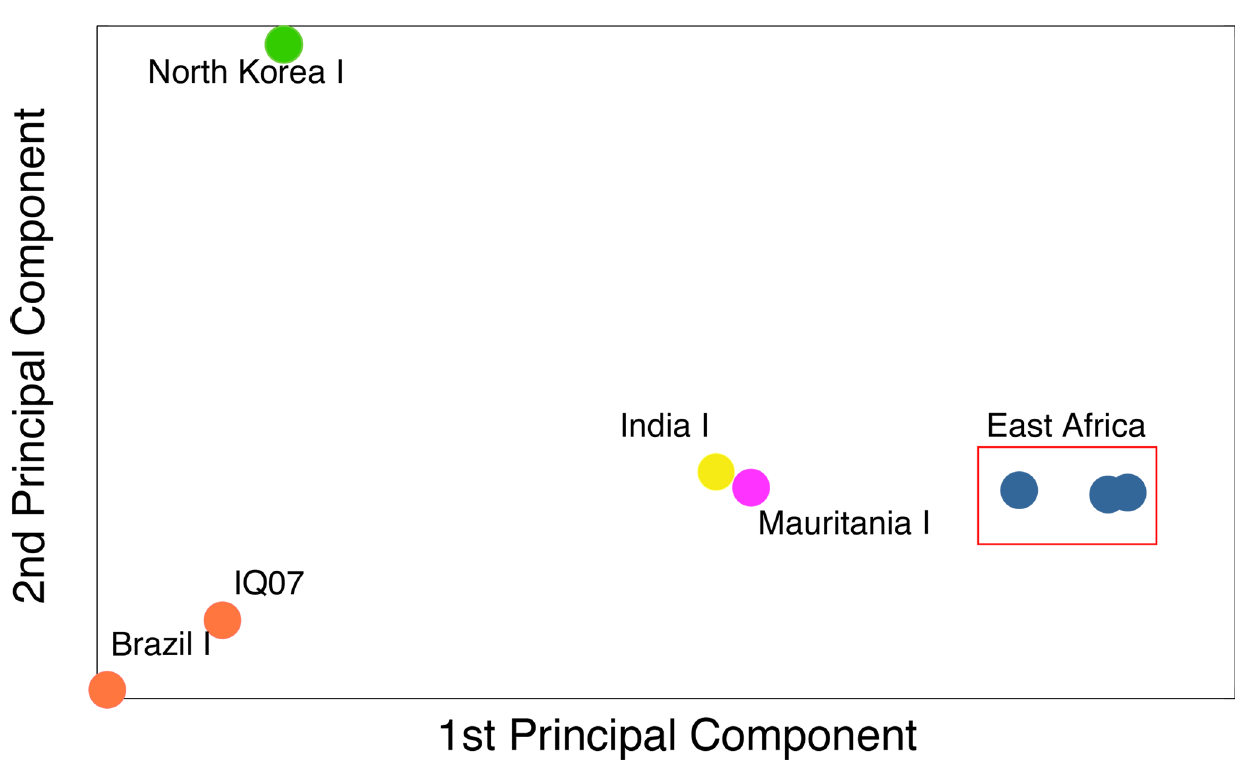
Figure 2. Principal components analysis. The East African samples sequenced in this study cluster by themselves as compared to the publicly available P. vivax samples that possess geographic information [North Korea I: SRP000316, Mauritania I: SRP000493, Brazil I: SRP007883, India VII: SRP007923, IQ07: SRP003406]. They are most closely related to IndiaVII and Mauritania I (West Africa). They are highly diverged from North Korea I and the South American strains. Principal components analysis was performed using